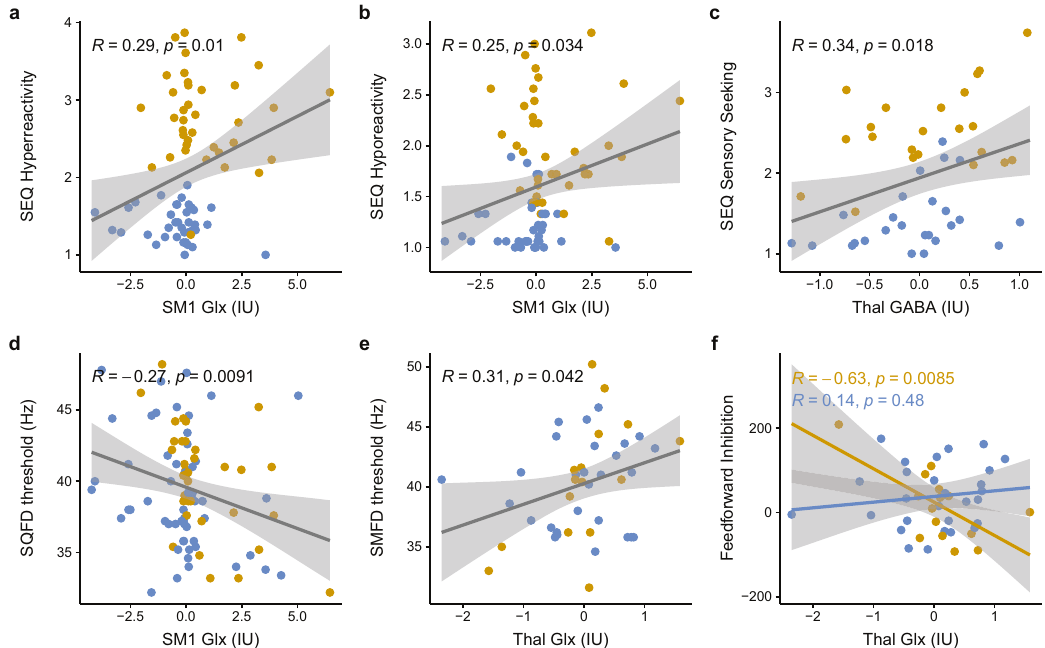
Fig. 4 Associations between Glx and GABA + of SM1 and Thal with sensory reactivity and tactile sensitivity. The ASD and TDC group are depicted as yellow and blue (respectively). Positive correlations were identi fi ed between Glx (IU) levels of SM1 and a Hyper- and b hyporeactivity scores on the SEQ. c Thal GABA (IU) levels also positively correlated with sensory seeking scores. d SM1 Glx (IU) levels showed evidence of a negative association to SQFD thresholds and e Thal Glx (IU) levels showed evidence of a positive association to SMFD thresholds. While we note that the associations presented in panel d and e do not survive correction for multiple comparisons, the associations were in the same direction when Glx was referenced to creatine, and the association in panel e was also stronger ( r = 0.41, p = 0.0062), suggesting that these associations were neither simply due to the reference variable or spurious. See Supplementary Results and Supplementary Fig. 2. f There was a strong negative association between Thal Glx (IU) levels and feedforward inhibition in the ASD group that was otherwise absent in the control group. Indeed, a similar pattern of effect (i.e., an interaction effect showing a negative association between Thal Glx and feedforward inhibition in the ASD group that is otherwise absent in the TDC group) was also identi fi ed when Glx was referenced to creatine. See Supplementary Results – Fig. 2f. IU institutional units, Glx glutamate + glutamine, Cr creatine, SM1 primary sensorimotor cortex, Thal thalamus, ASD autism spectrum disorders, TDC typically developing controls. Note: although the correlations in panels a – d are driven by extreme values on either end, the variables are approximately normally distributed at the whole sample level. This suggests that these measures are accurately representing the continuum of possible scores on each of the measures. Note: p -values presented on all panels are not corrected for multiple comparisons, please refer to the p -values in the main text. The shaded area around the line of best fi t represents the 95% con fi dence comparisons. There were no signi fi cant moderating effects of Group for any of the associations between SM1 Glx and tactile sensitivity (all p Bonferroni > 0.885). For Thal Glx levels, group collapsed correlation analyses found an association between Thal Glx and simultaneous frequency discrimination thresholds ( r = 0.31, p Bonferroni = 0.164; Fig. 4e), though this association also did not survive correction for multiple comparisons. Interestingly, however, there was some evidence for a moderating effect of Group on the association between Thal Glx and feedforward inhibition [ F (1, 40) = 7.35, p Bonferroni = 0.040, BF 10 = 0.349]. Simple slope analyses revealed that while Thal Glx showed no association to feedforward inhibition in TDC ( r = 0.14, p Bonferroni = 0.960), there was a strong negative association between Thal Glx and feedforward inhibition in ASD ( r = − 0.63, p Bonferroni = 0.018; Fig. 4f). No association between SM1 and Thal GABA + with tactile percep- tion . There were no signi fi cant associations between SM1 GABA + levels with any of the tactile perceptual thresholds (all p Bonferroni > 0.224), nor was there evidence of a moderating effect of Group for any of the associations (all p Bonferroni > 0.999). Like SM1 GABA + , there were no signi fi cant associations between Thal GABA + levels with any of the tactile perceptual thresholds (all p Bonferroni > 0.960), nor was there evidence of a moderating effect of Group (all p Bonferroni > 0.999).